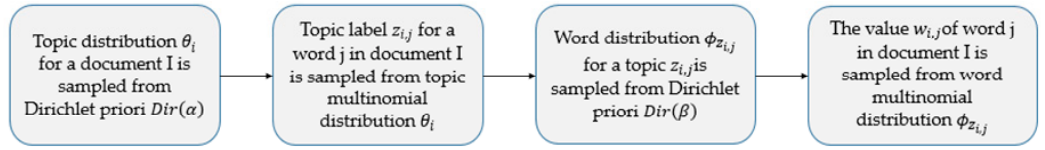
Figure 2. The generative procedure of LDA.